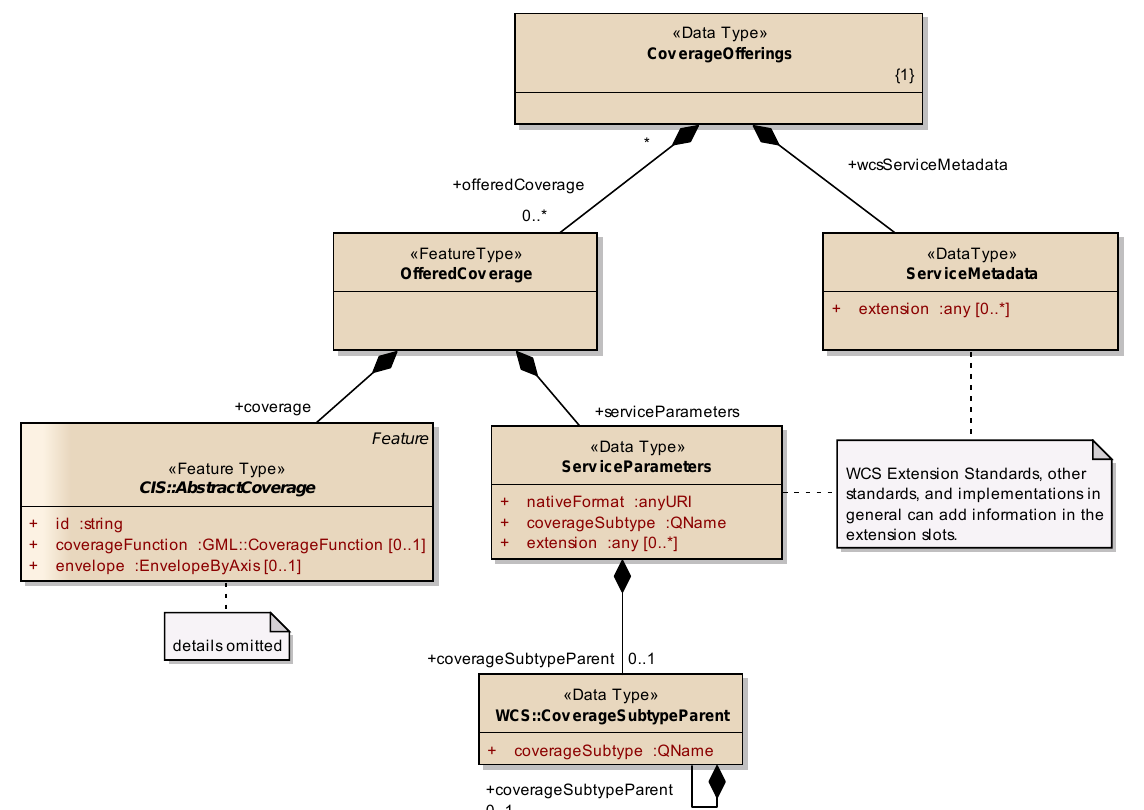
Figure 5. Conceptual model of a WCS offering [7]